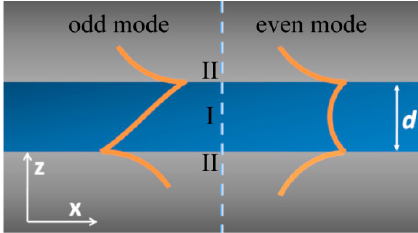
Figure 2. Schematic structure of metal–insulator–metal or insulator–metal–insulator (MIM or IMI) with d the thick core layer. The core layer and claddings are represented by Roman numbers “I” and “II”, respectively. The odd and even modes are represented by the orange-colored curve, respectively.